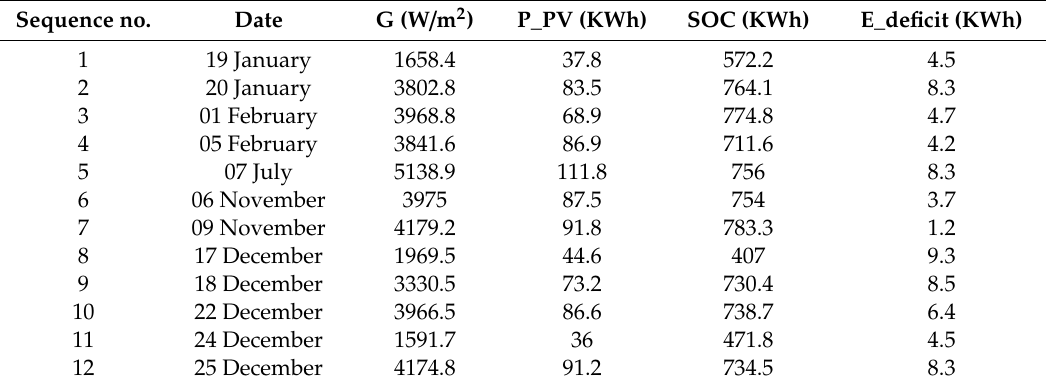
Table 11. Performance data of SAPV system during shortage of days.